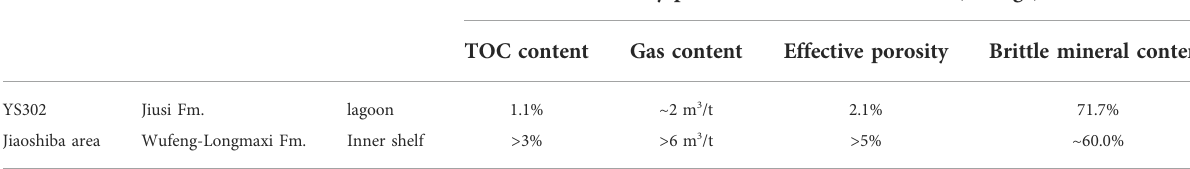
TABLE 7 Comparison of key parameters of sweet pot shale reservoir between YS302 and the Jiaoshiba area. Shale reservoir dataset of the Jiaoshiba area summarized from (Ma et al., 2018). Location